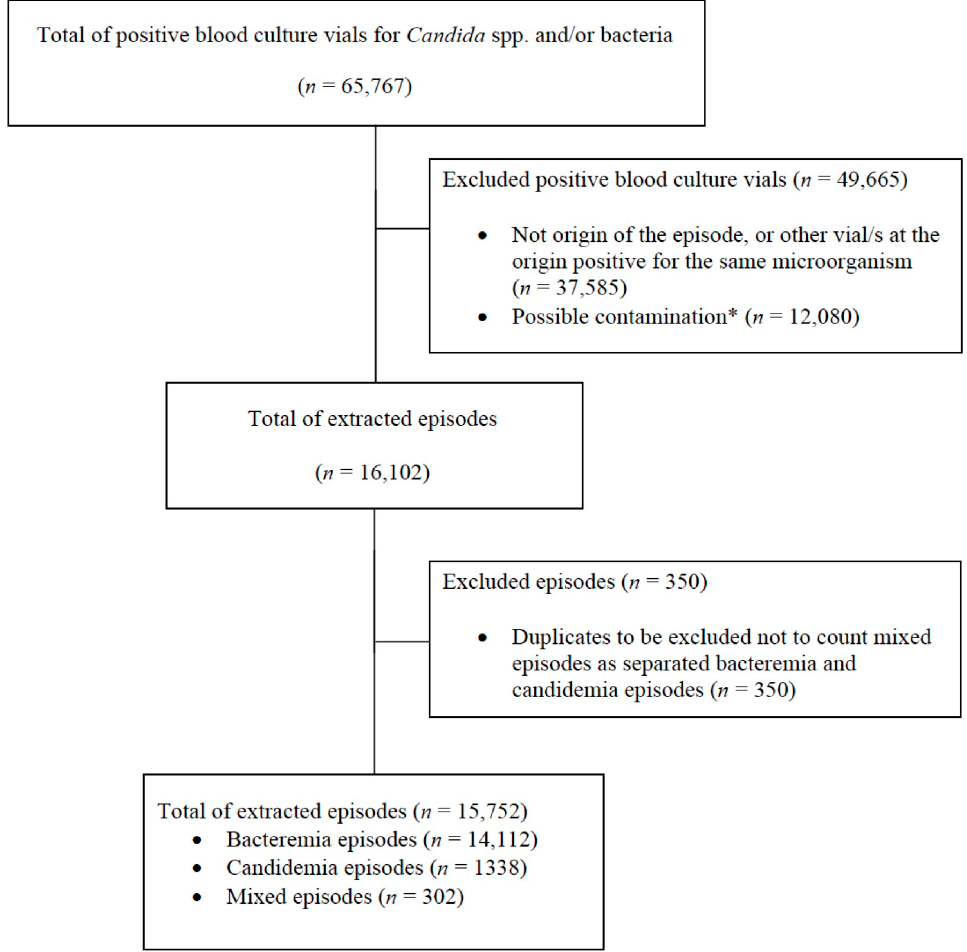
Figure 2. Flow-chart of the automated extraction process of candidemia and/or bacteremia episodes. Legend: * For the purposes of the AUTO-CAND project, we did not differentiate between the following: (i) contamination due to only one positive blood culture for common skin colonizers among multiple blood cultures performed; (ii) possible contamination when only one vial was sent to the laboratory and resulted positive for common skin colonizers. Indeed, the latter cases could represent true bacteremia episodes, but given the lack of certainty they also have to be excluded from the analyses of the second phase of the AUTO-CAND project. Should it be of interest for other future analyses/studies, the automated extraction system can be easily updated to also differentiate between (i) and